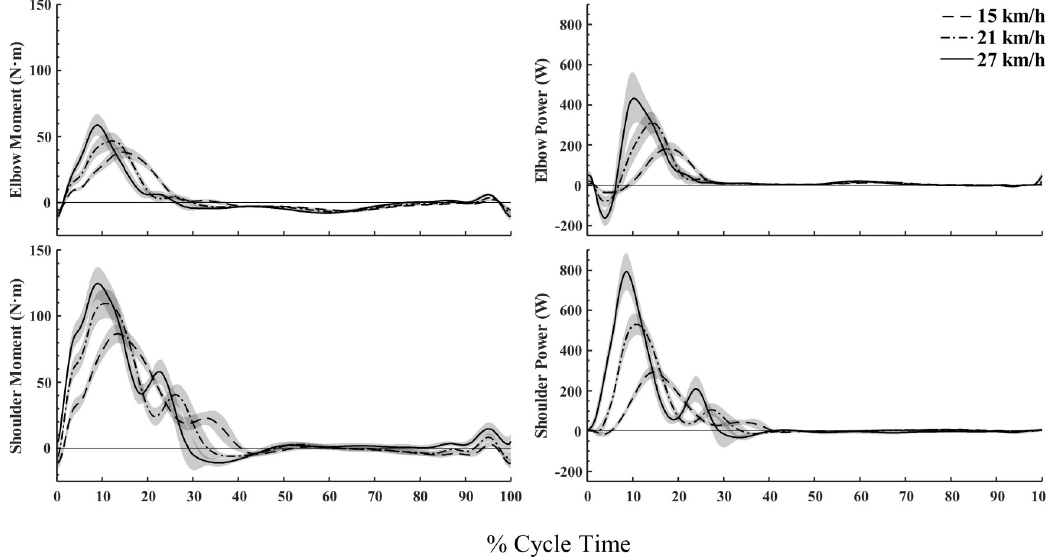
Fig 3. Net joint moment and joint power at the elbow and shoulder during double poling at increasing speeds on a 1% inclined treadmill. Plots are the average of all subjects [N = 14] with 95% CI indicated with shaded